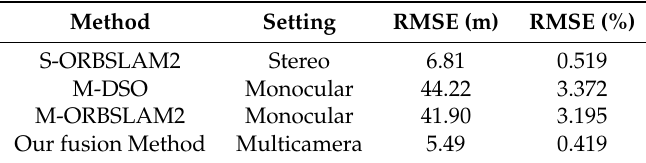
Figure 11. Trajectory obtained by four methods on sequence 05 in Oxofrd RobotCar Datasets. Table 3. Comparison of RMSE of four